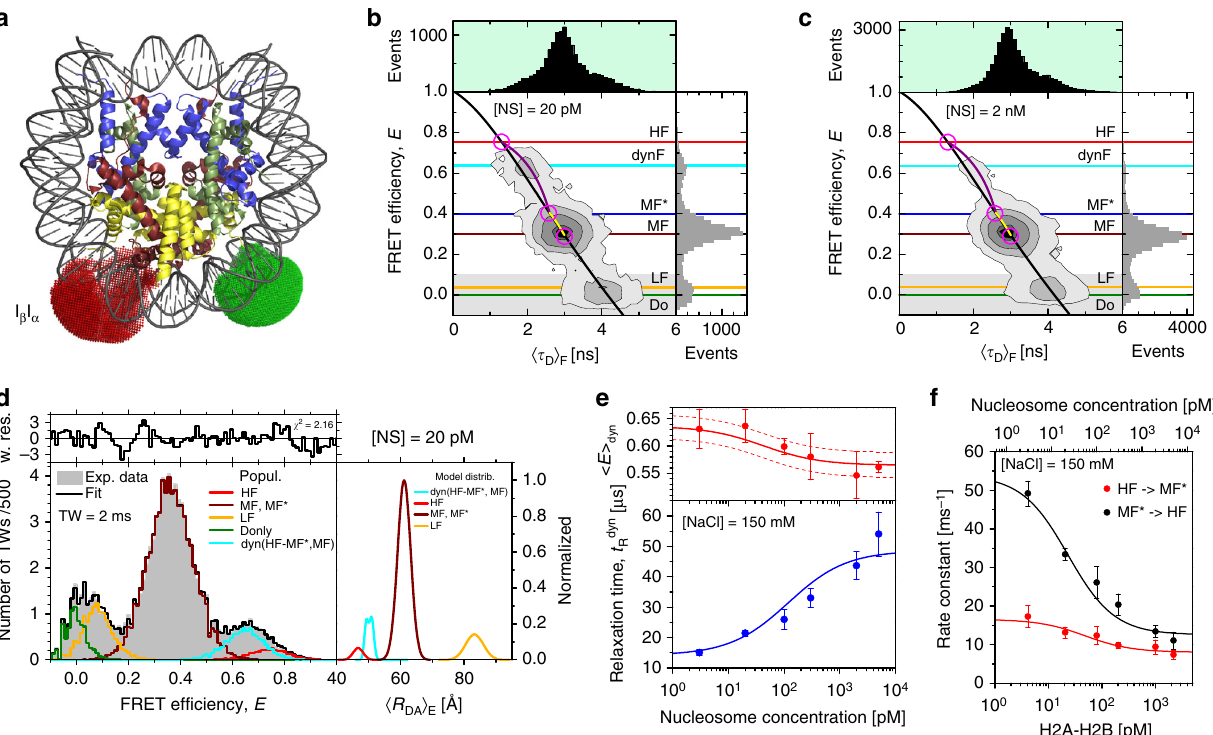
Fig. 4 Analysis of MFD smFRET data. Results of I β I α -wt nucleosome construct studied at 150 mM NaCl labeled with Alexa488 (donor) and Alexa594 (acceptor). a Crystal structure 3LZ1 and accessible fl uorophore volumes for donor (green) and acceptor (red). Histones are shown in blue (H3), pale green (H4), ruby (H2A) and yellow (H2B). b , c FRET ef fi ciency ( E ) versus donor lifetime ( 〈 τ D 〉 F ) for 20 pM and 2 nM (20 pM labeled and 1.98 nM unlabeled) nucleosomes. Color coded horizontal lines correspond to FRET ef fi ciency levels of different species. The E - 〈 τ D 〉 F relations are presented by black line for static FRET species (Supplementary Methods, Supplementary Equation 40), violet line - for dynamic interconversion between HF ( 〈 τ D 〉 F (HF) = 1.3 ns) and MF* ( 〈 τ D 〉 F (MF*) = 2.65 ns) states and by yellow hypothetical dynamic FRET line connecting MF* and MF. d dynPDA of data shown in b . Experimental FRET ef fi ciency histogram for 2 ms TW and fi tted distributions for a model with two interconverting species (MF* and HF) and three static components as Gaussian-distributed distances (MF, LF, and donor-only). The quality of the fi t is demonstrated by weighted residuals in the upper panel. The right panel shows the model with the intrinsic distribution of 〈 R DA 〉 E for the limit of large photon counts (shot noise free). e Relaxation times t dyn